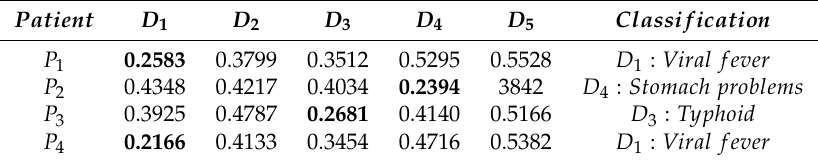
Table 7. The results generated by the Xiao method in Example 4.